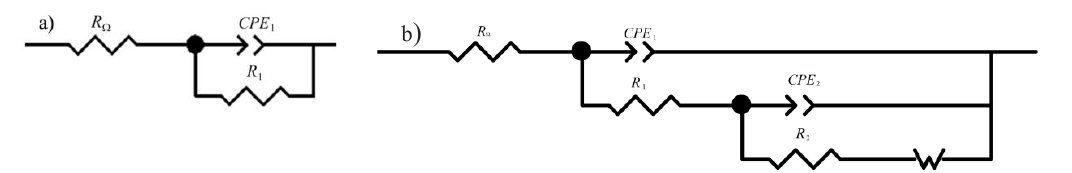
Figure 4: Electrical equivalent circuits used to fit the impedance spectra of Fe electrode (a) in the absence of extract and (b) in the presence of SM and PF.